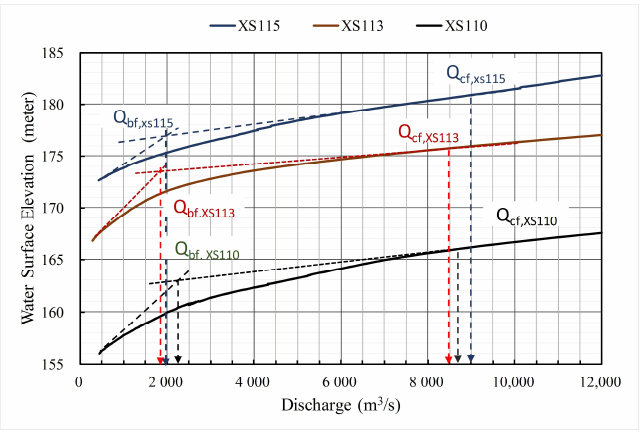
Figure 8. The stage–discharge relations computed by SRH-2D at three cross sections of the bedrock- exposed reach.